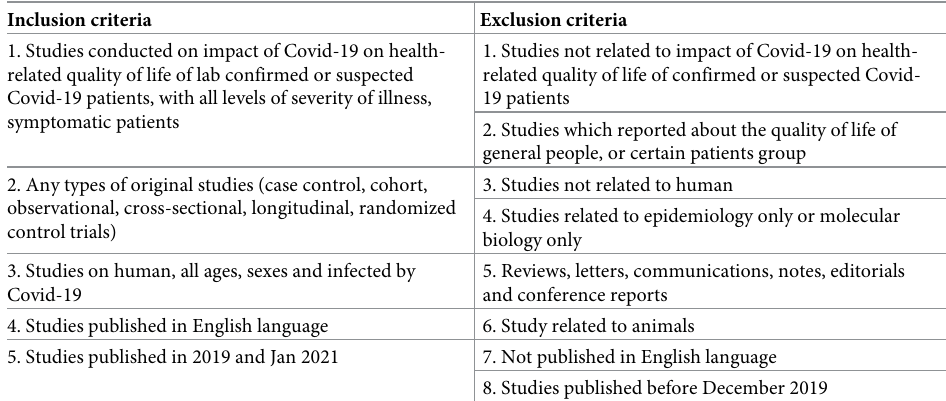
Table 1. Eligibility